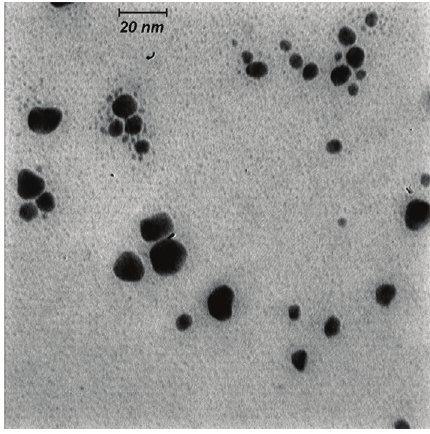
Fig 1.TEM image of